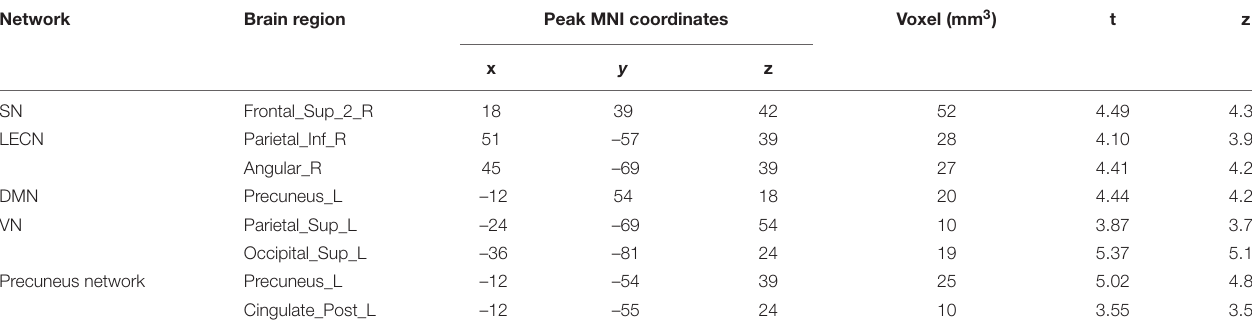
FIGURE 2 | The brain regions with a significant difference in patients with type 2 diabetes mellitus. (A) Significant difference in internal network connectivity in the SN. (B) Significant difference in internal network connectivity in the LECN. (C) Significant difference in internal network connectivity in the DMN. (D) Significant difference in internal network connectivity in the SN. (E) Significant difference in internal network connectivity in the precuneus network. The significance threshold was set at p < 0.05 (false discovery rate-corrected). TABLE 2 | Abnormal internal network connectivity in patients with type 2 diabetes mellitus compared to normal controls. Network Brain region Peak MNI coordinates Voxel (mm 3